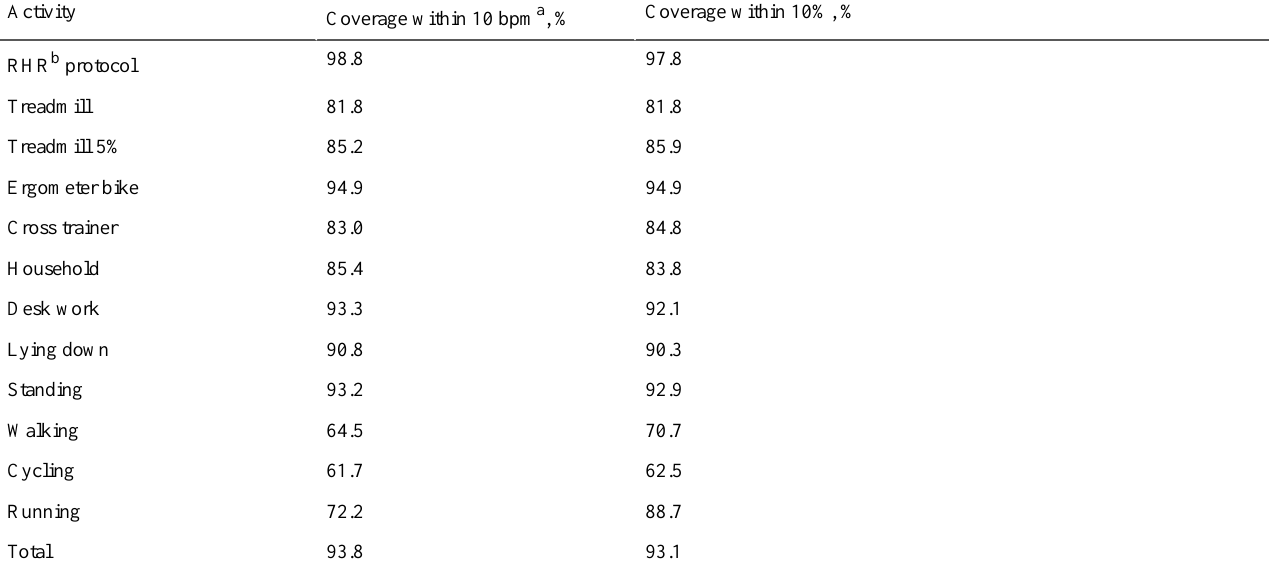
Table 5. Heart rate coverage parameters calculated using 10-second nonoverlapping windows for the individual activities as well as for the whole